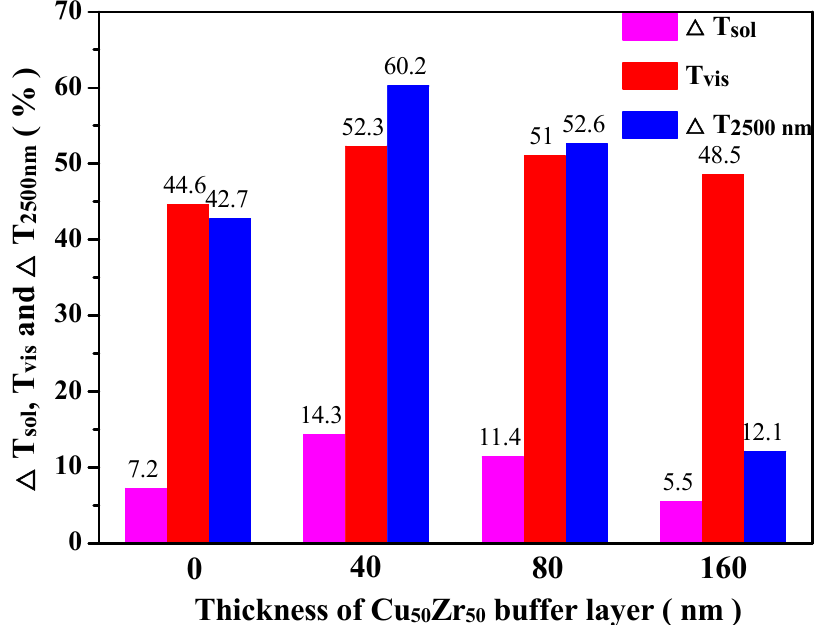
Figure 6. Summarized optical properties of the VO 2 /Cu 50 Zr 50 /glass thin films with different buffer layer thicknesses.